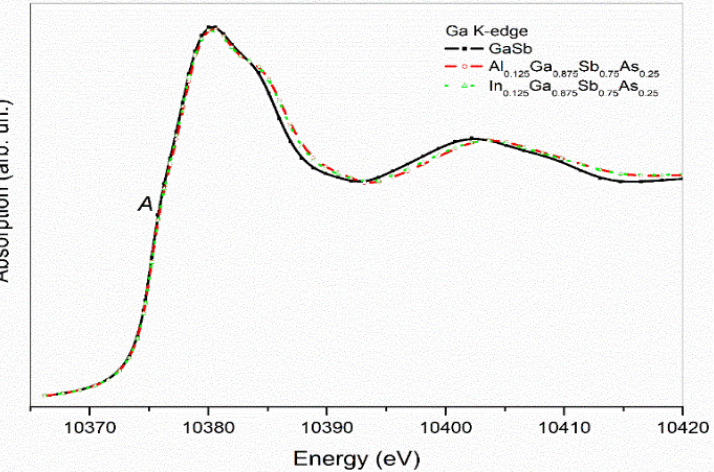
Figure 2. Ga K ‐ edge XANES spectra of GaSb, (Al, In) 0.125 Ga 0.875 Sb 0.75 As 0.25 nanostructured material. Data within this region contains information about configurations of neighboring at ‐ oms, atomic distances, and coordination numbers. where Ga atoms are the source atom, i.e., photoelectron emitter.